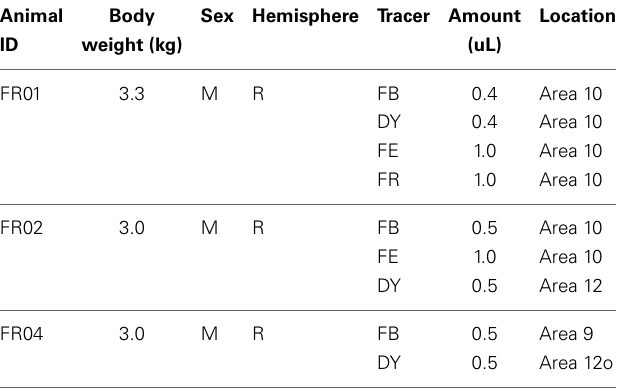
Table 1 | Case information and tracer injection